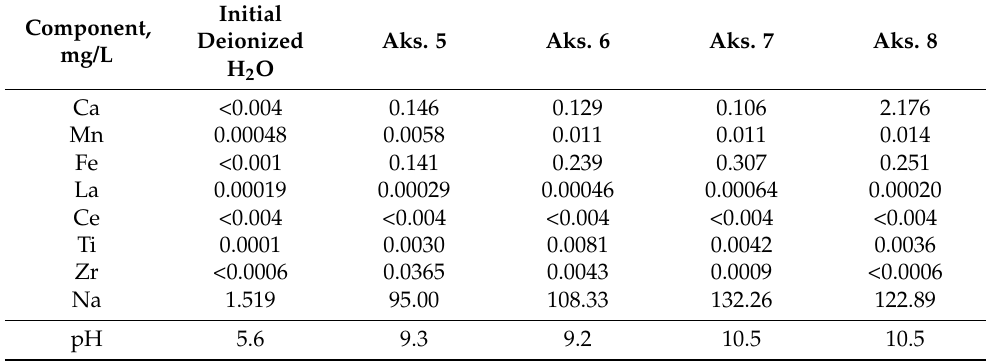
Table 6. Chemical composition (mg/L) and pH of both deionized H 2 O and solutions after experiments.